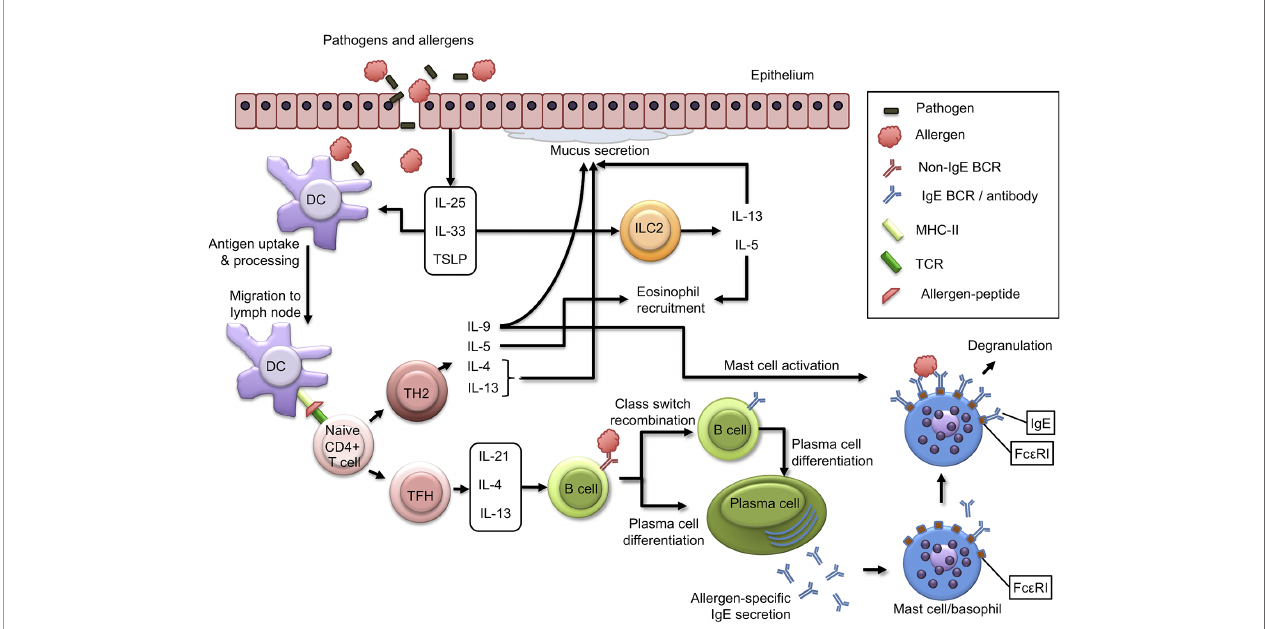
FIGURE 1 | Immunological mechanisms of allergic sensitization. Epithelial cells produce alarmins such as IL-25, IL-33, and TSLP in response to external insults. These cytokines are central regulators of type 2 immunity, as they act on dendritic cells to induce TH2 responses and activate ILC2 cells leading to production of IL-13 and IL-5. Allergens and pathogens that pass skin or mucosal epithelial barriers are captured and processed by dendritic cells (DCs), which in turn migrate to draining lymph nodes, where they present allergen-derived peptides on MHC class II molecules to naïve T cells, which in turn (depending on co-stimulatory and cytokine signals) can differentiate to TH2 cells or TFH cells. TH2 cells produce type 2 cytokines such as IL-4, IL-13, IL-5, and IL-9, and function as effector cells that drive many aspects of allergic in fl ammatory responses. TFH cells produce IL-21, IL-4, and IL-13 and induce IgE class switch recombination in B cells, plasma cell differentiation and allergen-speci fi c IgE production. Plasma cell produce allergen-speci fi c IgE antibodies that are released into circulation and can bind to Fc ϵ RI molecules on mast cells and basophils. Subsequent exposure to allergen can result in mast cell and basophil